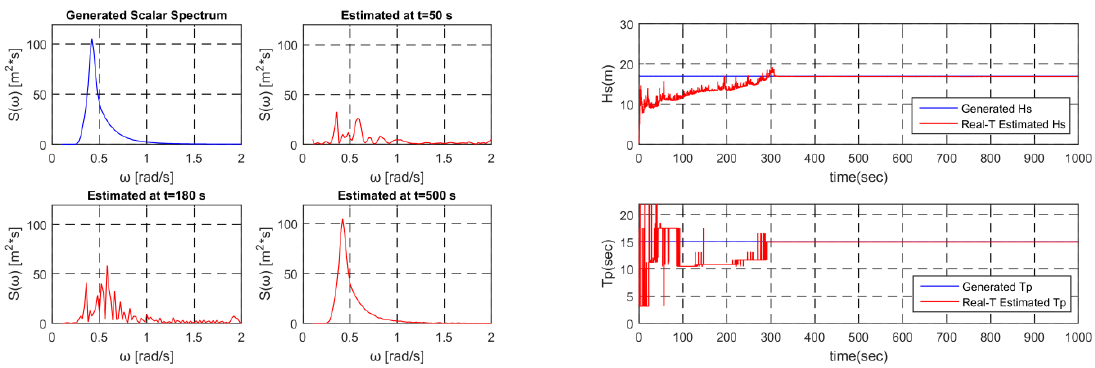
Figure 32. Generated and estimated spectrum / Evolution of parameters (Sea sate 5, Hs = 17 m, Tp = 15 s).